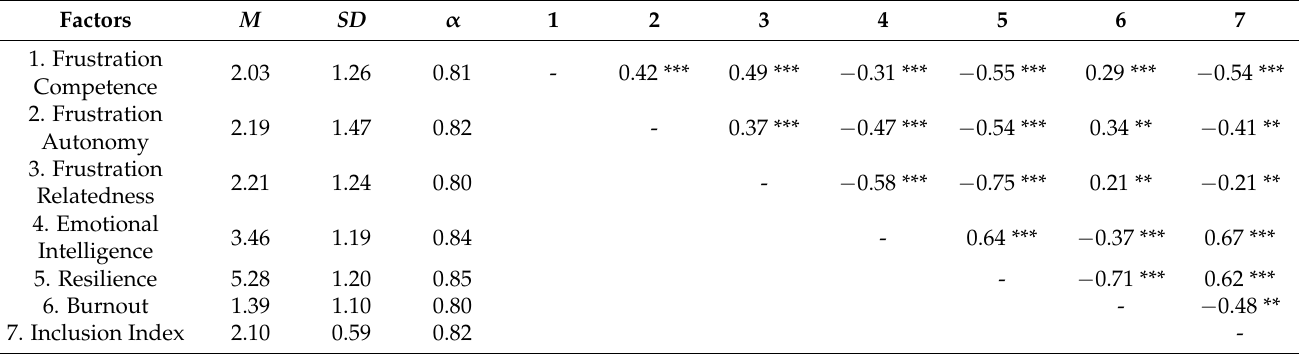
Table 1. Mean, standard deviation, internal consistency analysis and bivariate